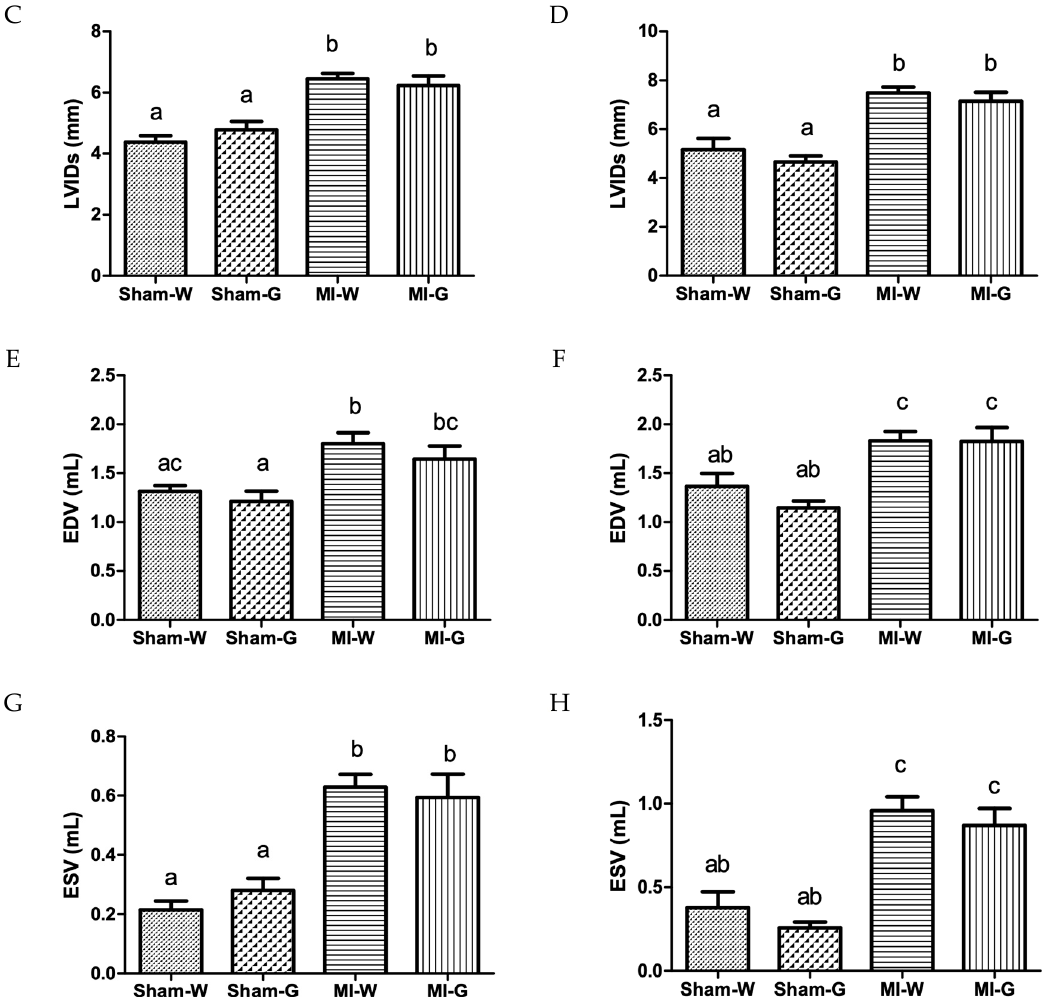
Figure 1. Effect of ginseng berry extract on ventricular chamber dilatation and remodeling. ( A ) LV internal diameter at diastole (LVIDd) at 4 weeks; ( B ) LVIDd at 8 weeks; ( C ) LV internal diameter at systole (LVIDs) at 4 weeks; ( D ) LVIDs at 8 weeks; ( E ) end diastolic volume (EDV) at 4 weeks; ( F ) EDV at 8 weeks; ( G ) end systolic volume (ESV) at 4 weeks; ( H ) ESV at 8 weeks. Values presented are mean ± SEM. Bars with differing letter are significantly different, p < 0.05. Sham-W: Sham MI treated with distilled water ( n = 8); Sham-G: Sham MI treated with GBE 150 mg/kg/body weight/day ( n = 8); MI-W: MI treated with distilled water ( n = 12–14); MI-G: MI treated with GBE 150 mg/kg/body weight/day ( n = 12 – 14).